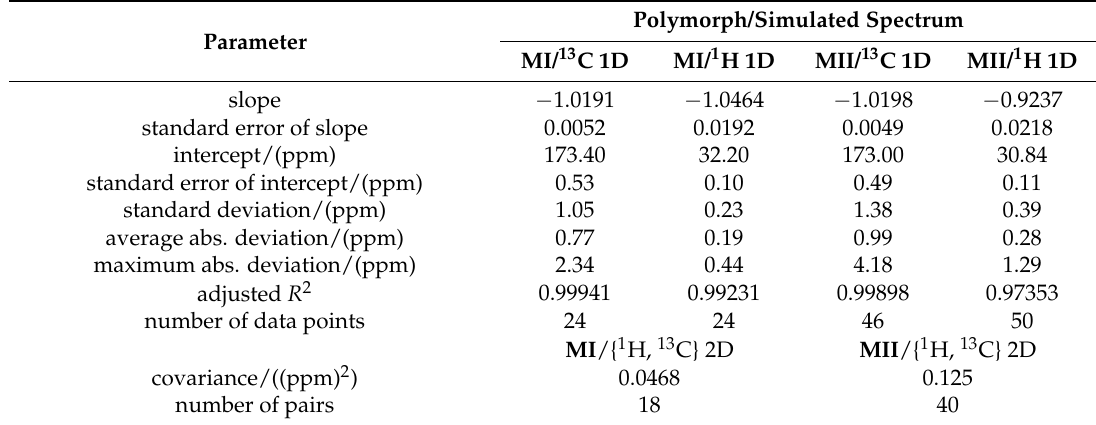
Table 1. Statistical evaluation of the agreement between the GIPAW-RPBE chemical shieldings and experimental chemical shifts for the polymorphs of